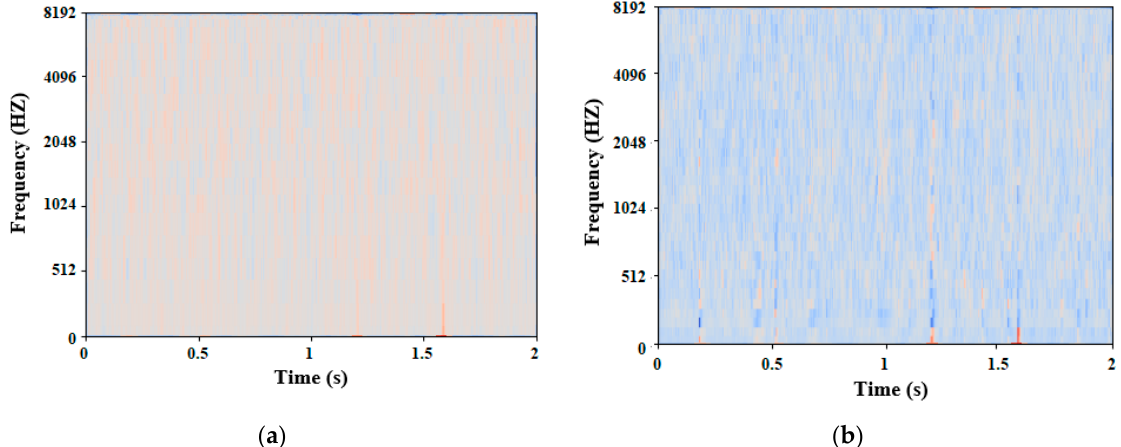
Figure 5. Features extraction results of underwater acoustic signals with a signals-to-noise ratio 10 dB: ( a ) Features of MFCC in underwater acoustic signals with a signals-to-noise ratio 10 dB; ( b ) Features of the GFCC in underwater acoustic signals with a signals-to-noise ratio 10 dB.